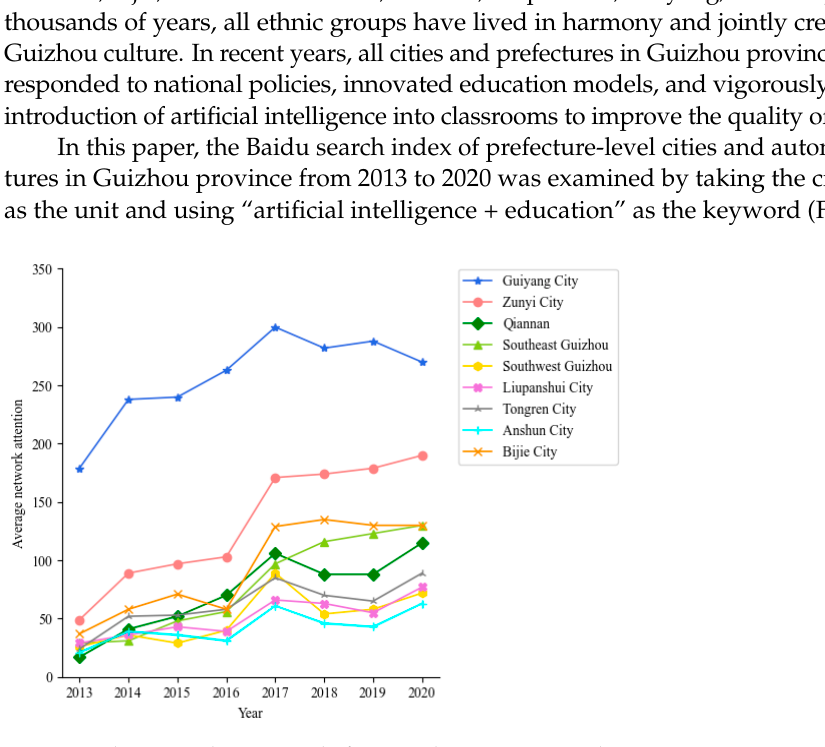
Figure 4. The mean change trend of “AI + education” network attention in various cities (prefectures) of Guizhou province from 2013 to 2020.